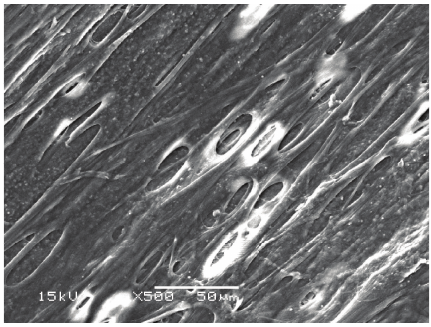
Figure 2: SEM of untreated tissue showing regular and intact tra- becular